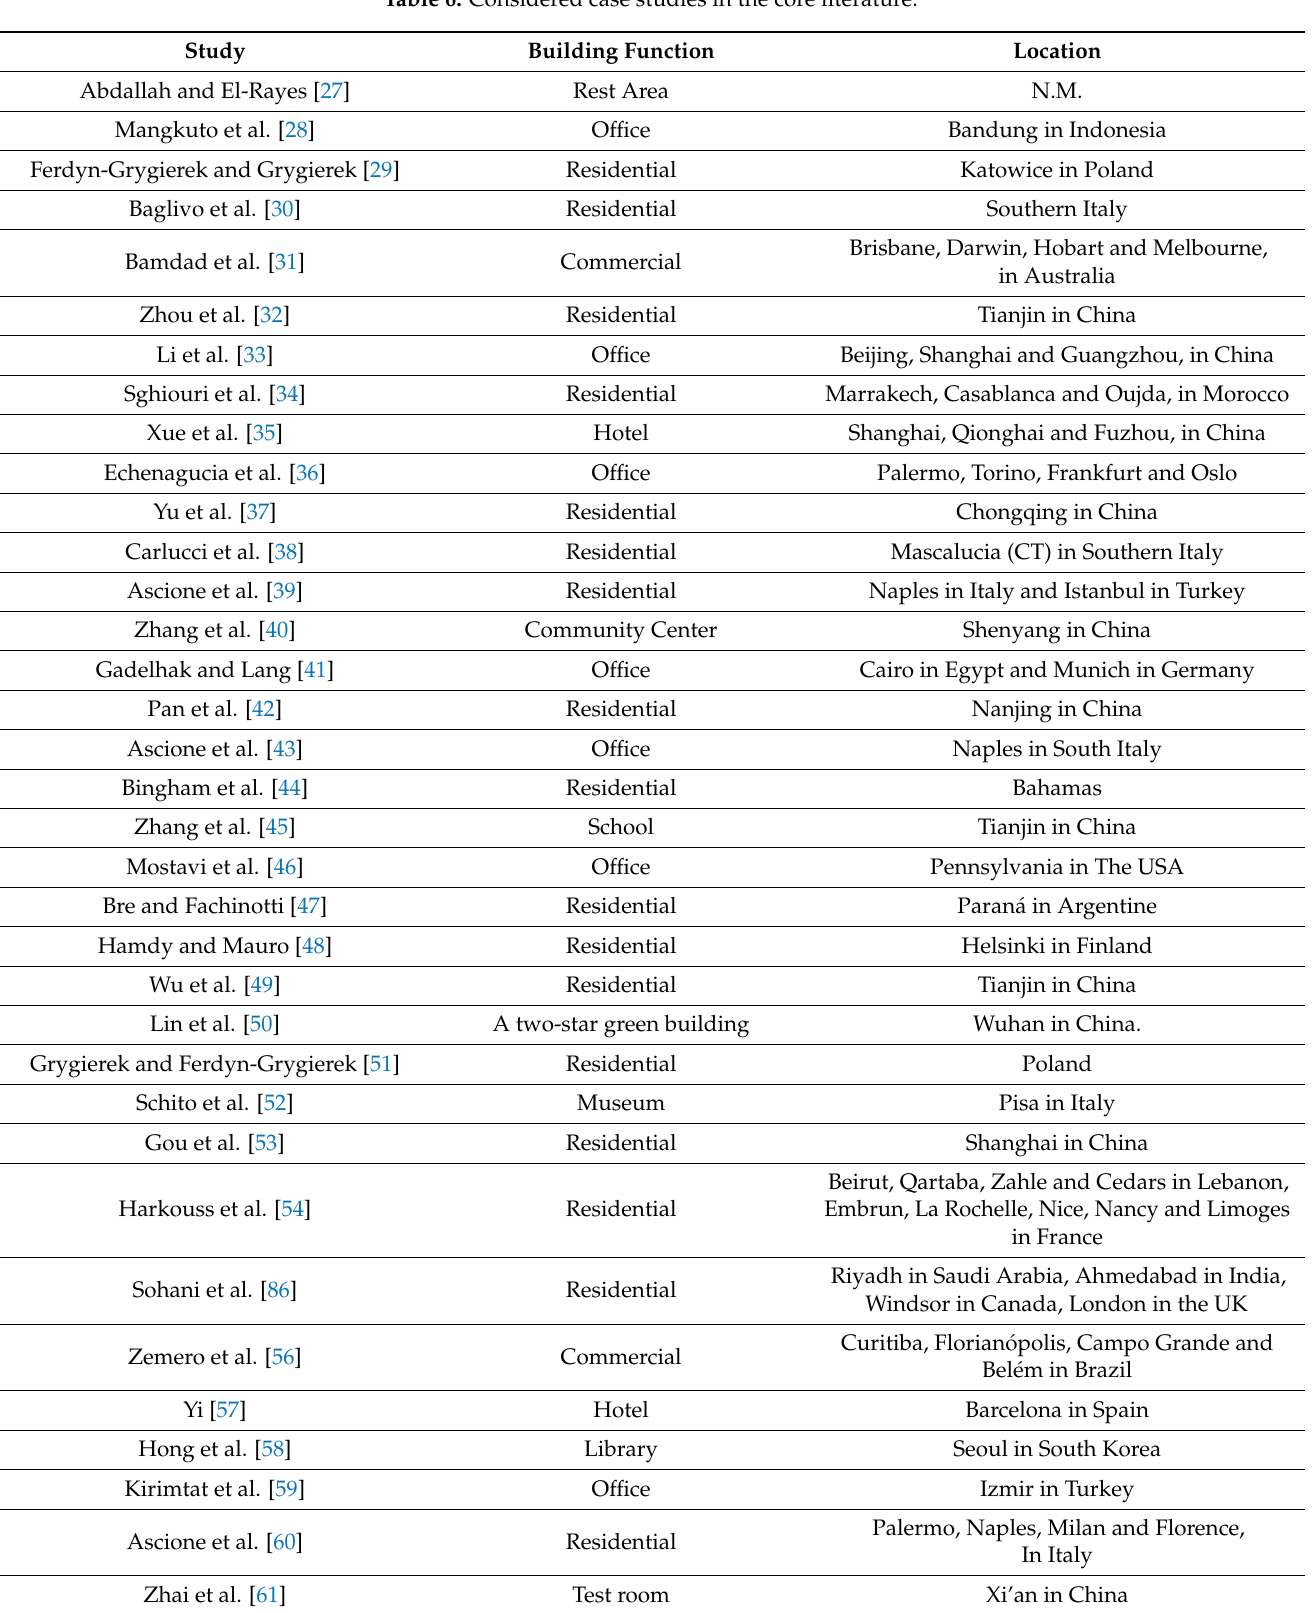
Table 6. Considered case studies in the core